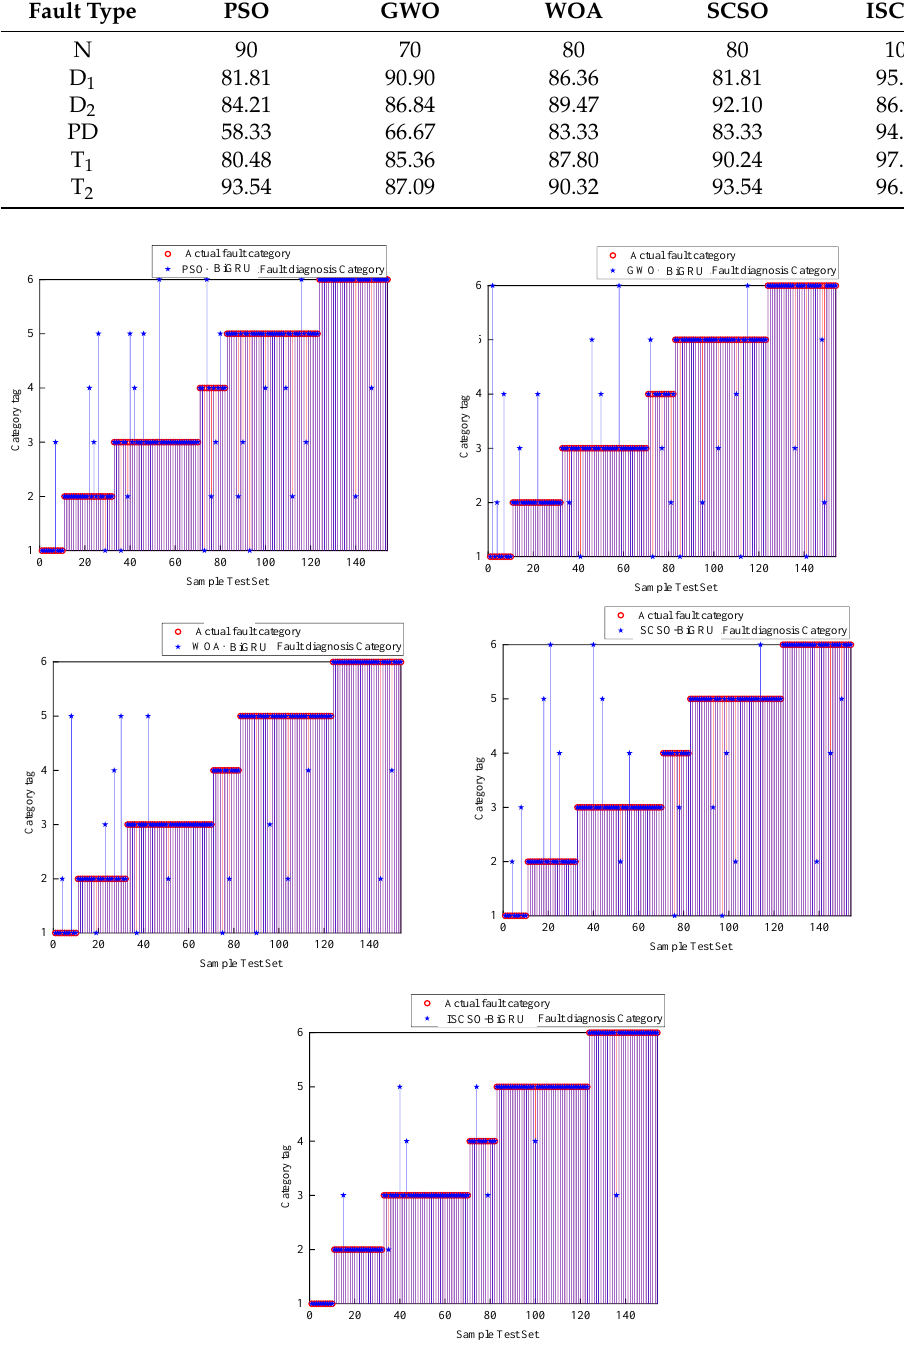
Figure 21. Fault diagnosis results.